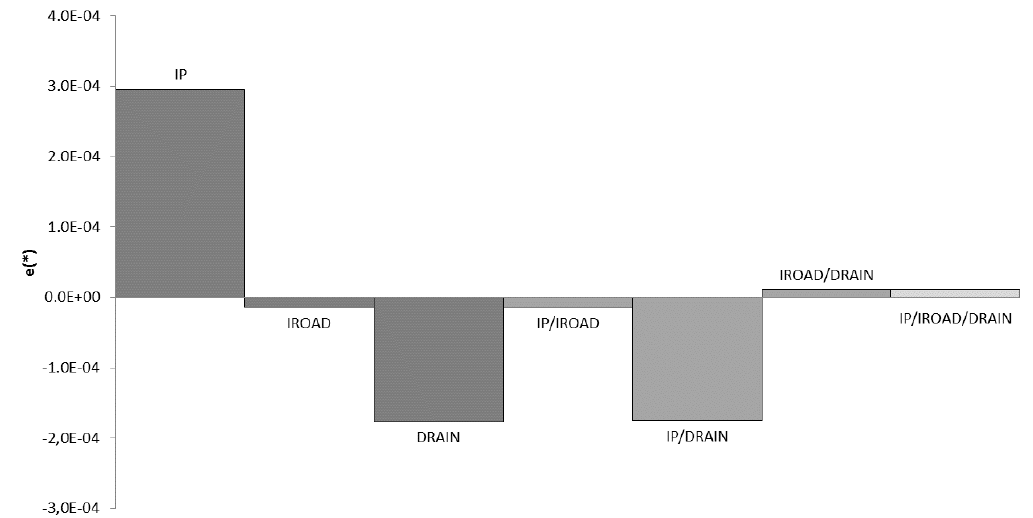
Figure 6. Calculated effects on the model response ( R sew ) from parameters I p , I rd and D ∗ and their interactions (dark shade of grey: principal effects; medium grey: second-order effects; and light grey: third-order effects).